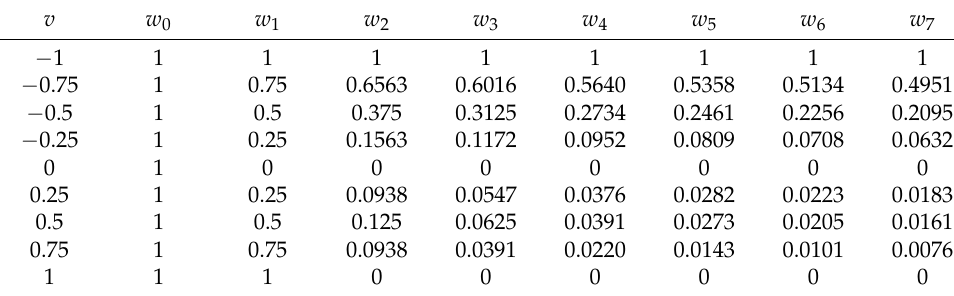
Table 2. The weighting coefficient changes with fractional-order v .